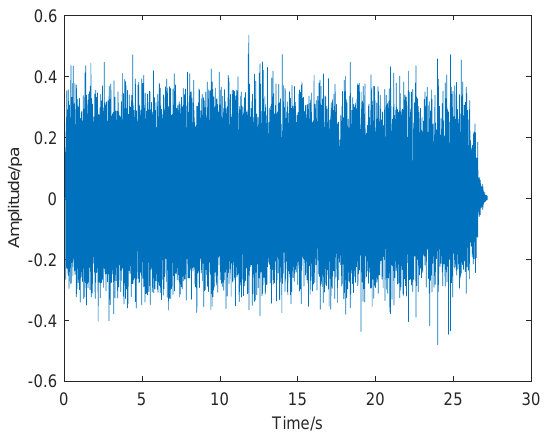
Figure 14. Time-domain sound signal.